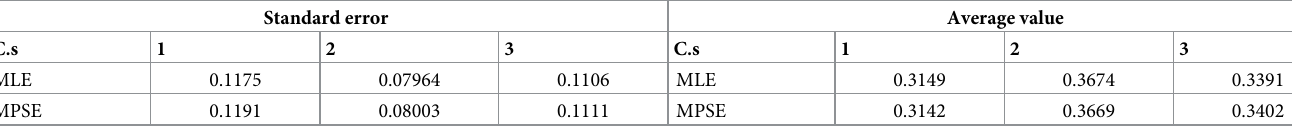
Table 21. Standard error and average value for each estimate after bootstrapping for example